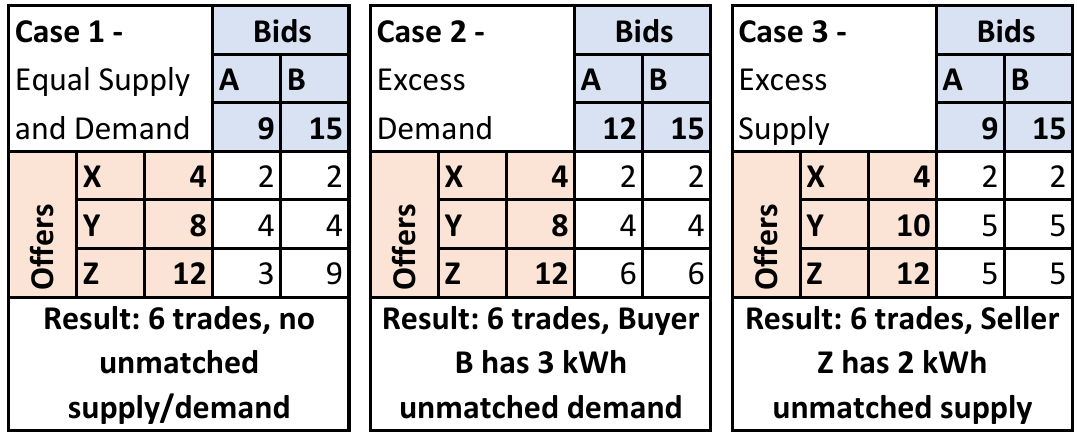
Figure 6. Example of allocation procedure for P2P